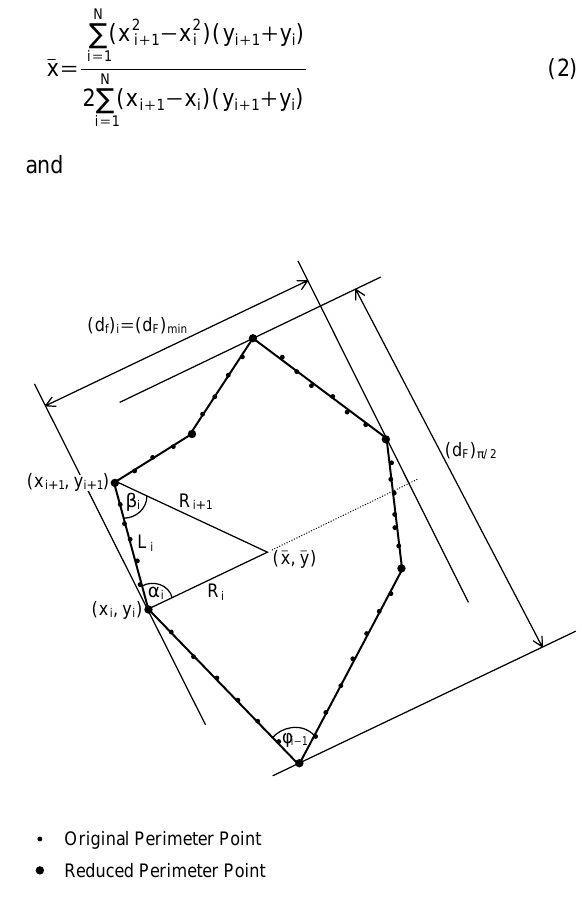
Representation of a particle profile consisting of N perime- ter points (N (cid:3) 40 in this example) by a fitted polygon defined by a set of n reduced perimeter points (n (cid:3) 7 in this